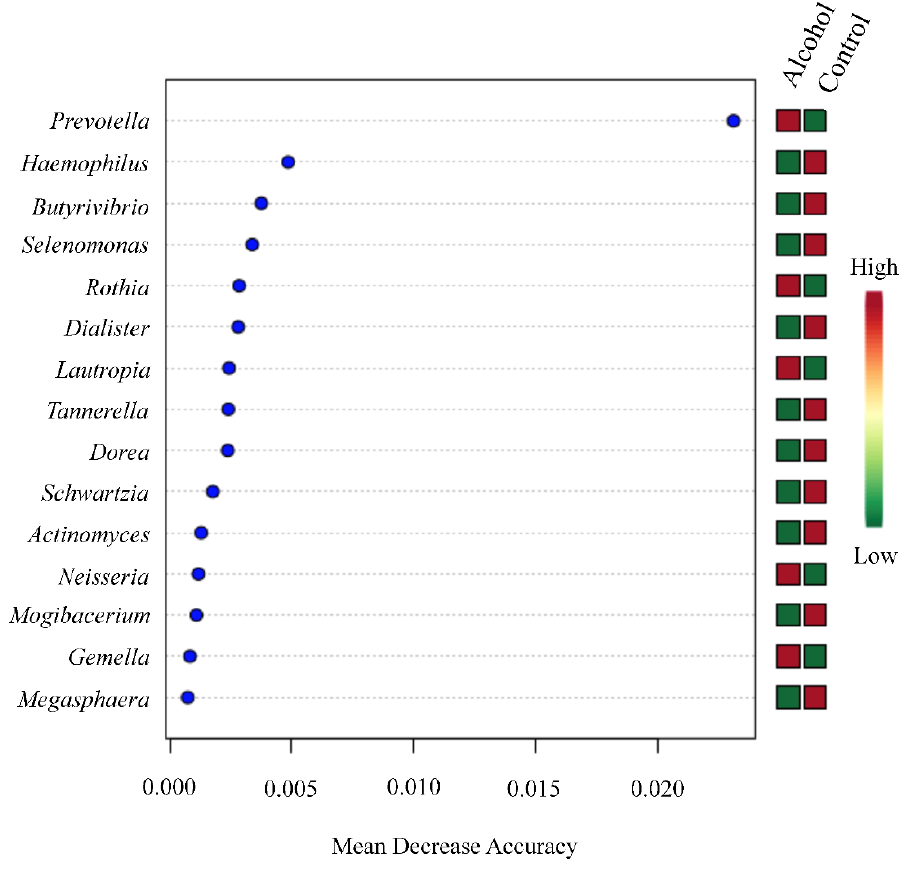
Figure 6. Random forests ranked by contributions to classification accuracy (mean decreased accuracy). The random forest analysis, which is an algorithm suitable method for high dimensional data analysis, was performed by using the ensemble of classification trees by random feature selection from a bootstrap sample at each branch. The 15 more important genera were classified based in their mean decreased in accuracy (high = red, low = green).